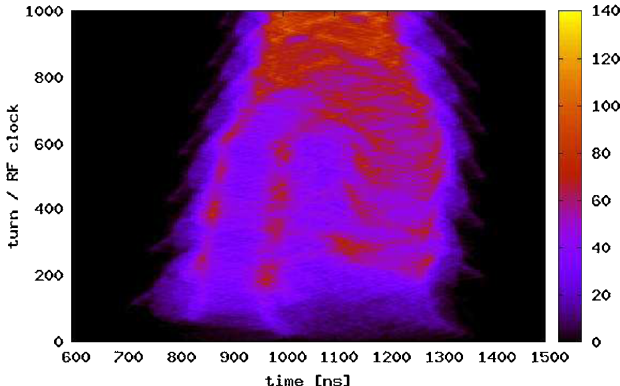
FIG. 13. (Color) Mountain plots of the simulated beam, with 80% second harmonic, momentum offset of (cid:1) 0 : 2% , and phase sweep of 80